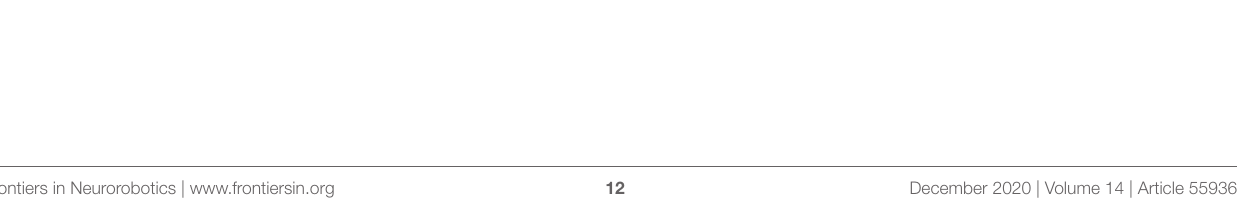
Frontiers in Neurorobotics |